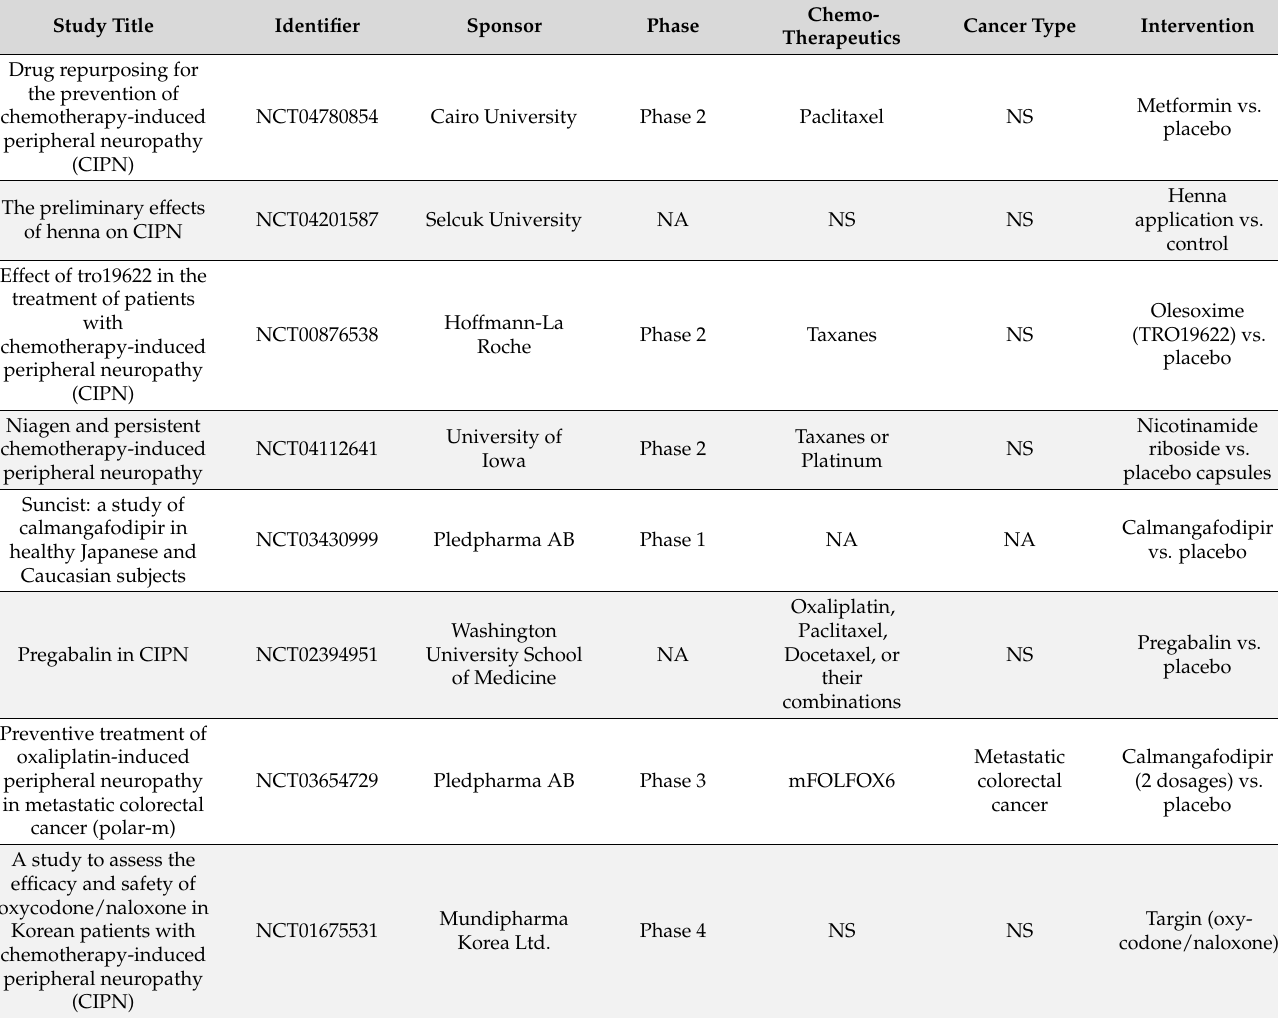
Table 2. Current clinical trials for chemotherapy-induced peripheral neuropathy